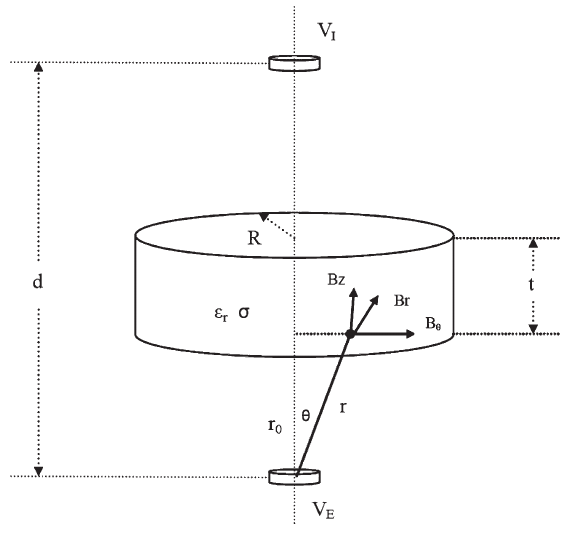
Figure 1. Magnetic field in a cylinder due to an excitation coil (shown in polar coordinates). A cylinder of radius R and thickness t was placed centrally and midway between a small excitation coil and a small detection coil separated by distance d. The cylinder had a conductivity of s , a relative permittivity of e c and a permeability of m 0